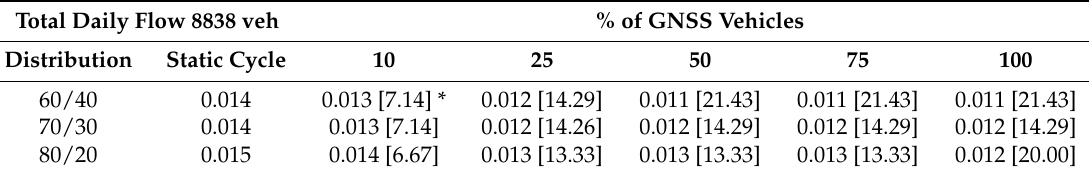
Table 12. Average PM pollution [g/km], in a typical day, for Case